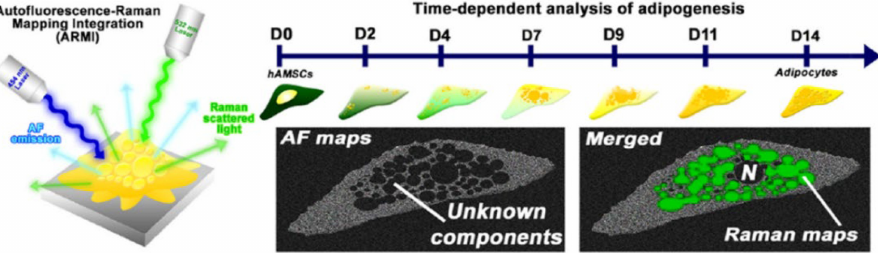
Figure 3. Schematic illustration of AF-Raman mapping analysis. Reprinted with permission from Ref. [175]. Copyright 2021 Elsevier.